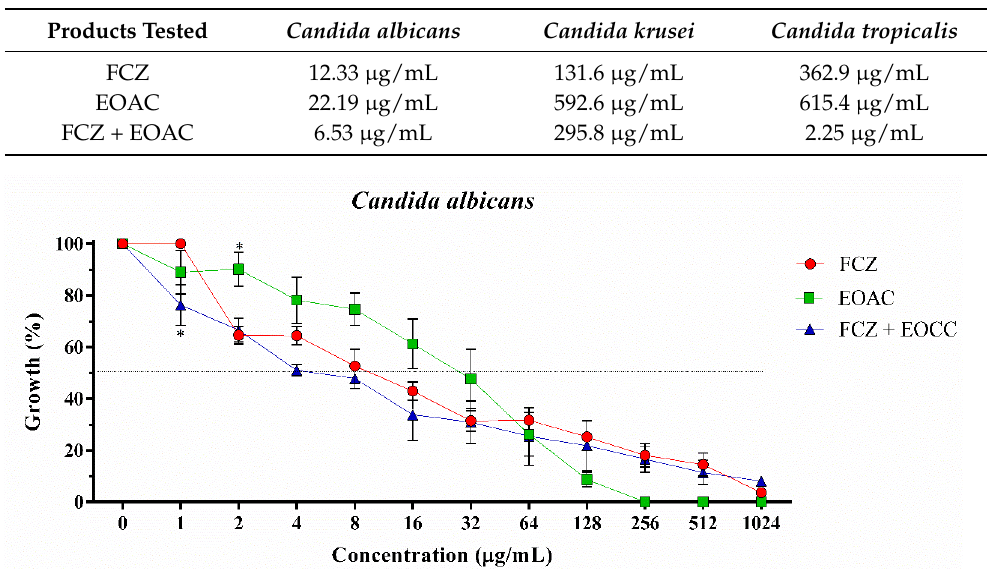
Table 2. IC 50 of the essential oil of Acritopappus confertus (EOAC) and fluconazole (FCZ) against